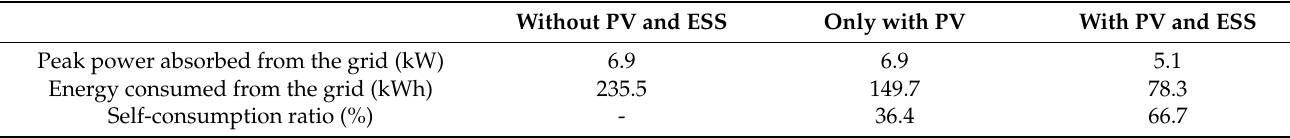
Figure 10. Operation of the microgrid and the battery over five days. ( a ) Energy balance of the microgrid, ( b ) measured battery current and voltage, ( c ) SOC estimated by the ES. Table 3. Main parameters of the microgrid for different